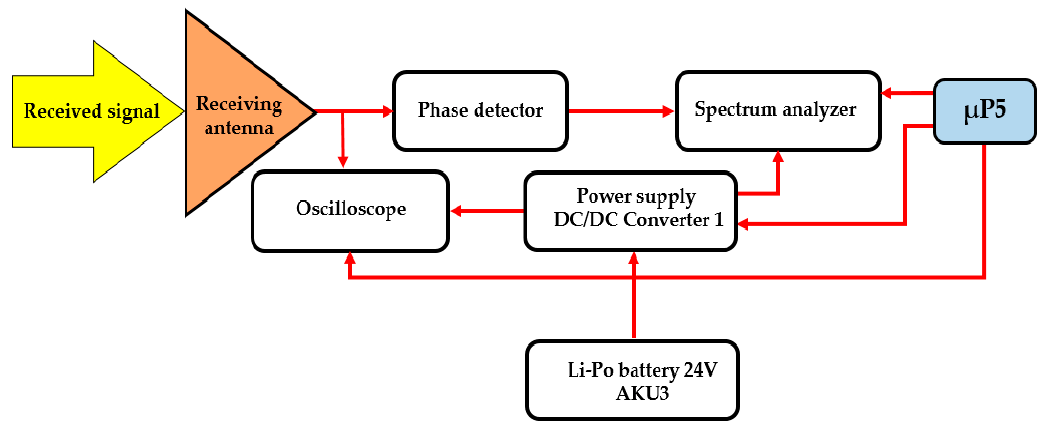
Figure 12. Block diagram for receiving parts.